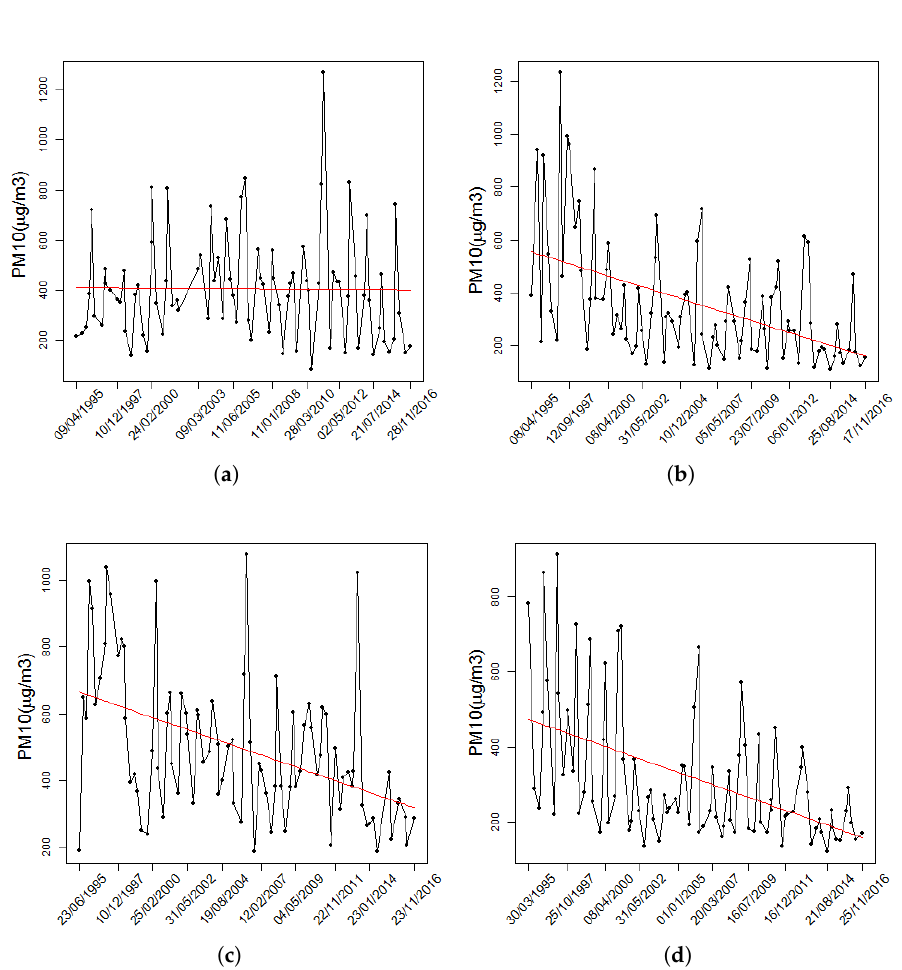
Figure 3. Example of quarterly block maxima of PM 10 levels at ( a ) VIF = Villa Flores; ( b ) MER = Merced; ( c ) XAL = Xalostoc and ( d ) TLA = Tlanepantla. Linear trend over time are indicated in